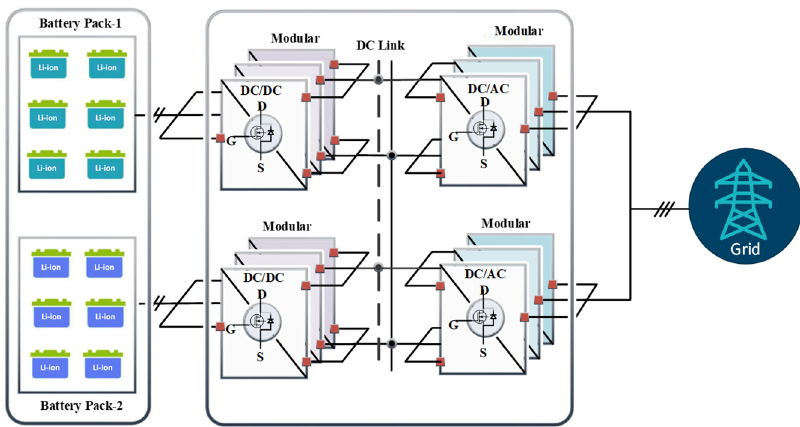
Figure 3. PE configuration 2: only PCS-2 is used.